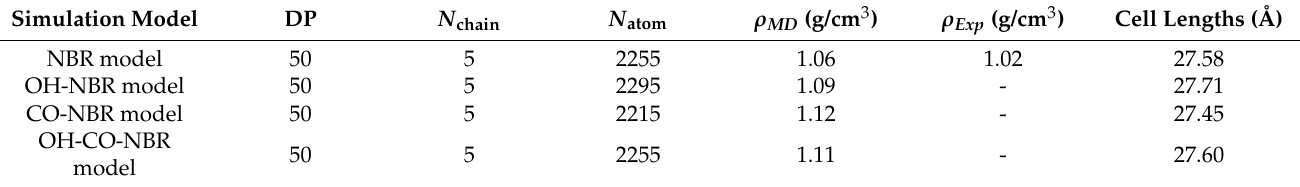
Table 1. Details of the simulation models.